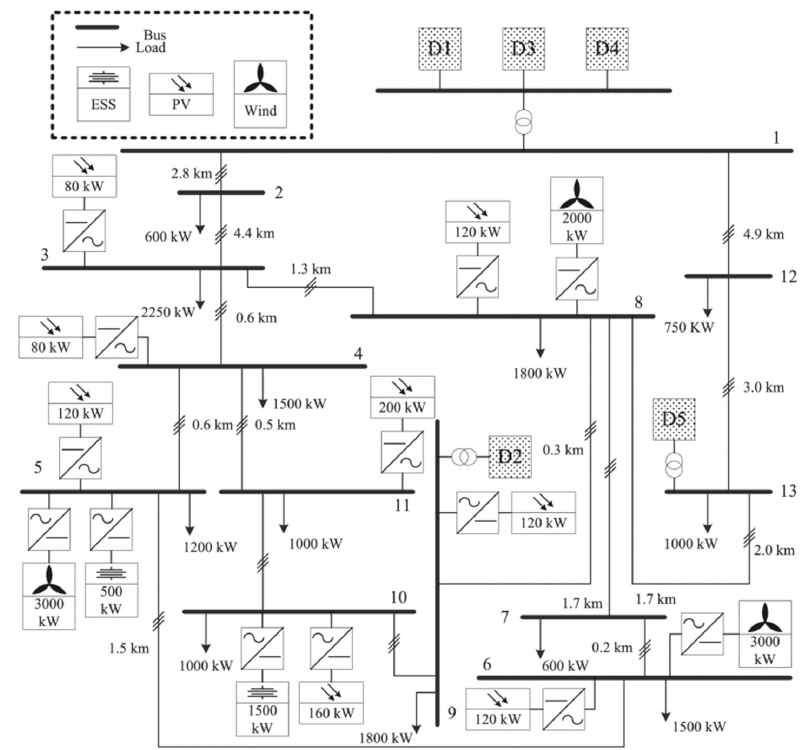
Figure 13. A CIGRE microgrid benchmark test system [132].